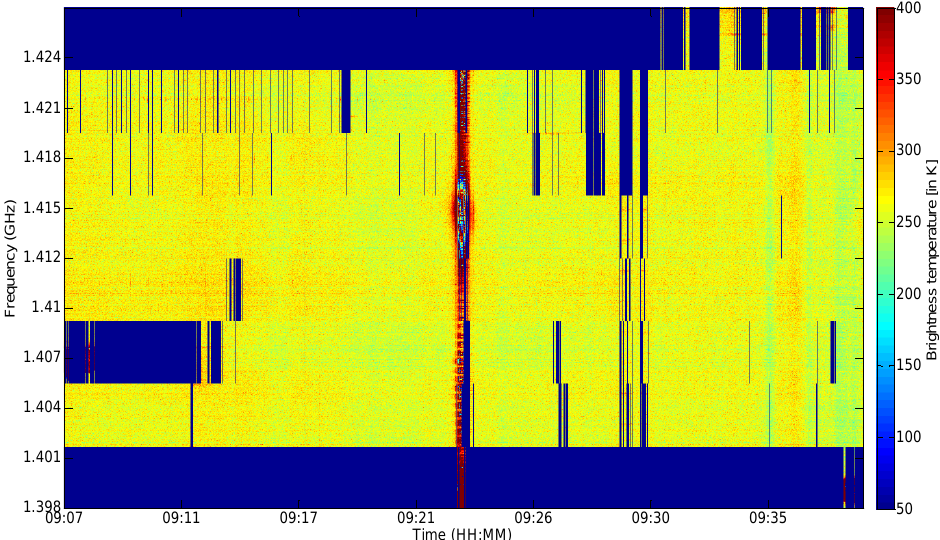
Figure 5. Spectral filtering using the kurtosis filter, and with the spectrum divided into 8 sub-bands. Mask Kurtosis with 8